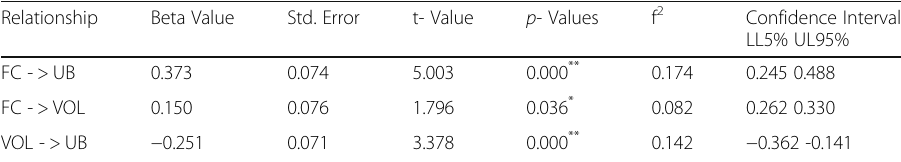
Table 5 Results of paths